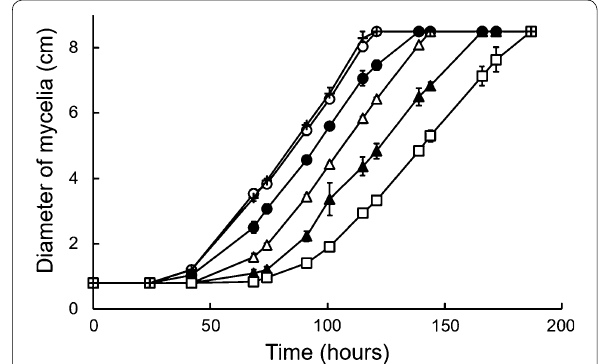
Fig. 2 Time courses of B. adusta Dec 1 mycelia growth on PD plates containing different concentrations of alizarin. Crosses, 0 μM alizarin without DMSO; open circles, 0 μM alizarin with 0.64% DMSO; closed circles, 1 μM alizarin; open triangles, 3.2 μM alizarin; closed triangles,